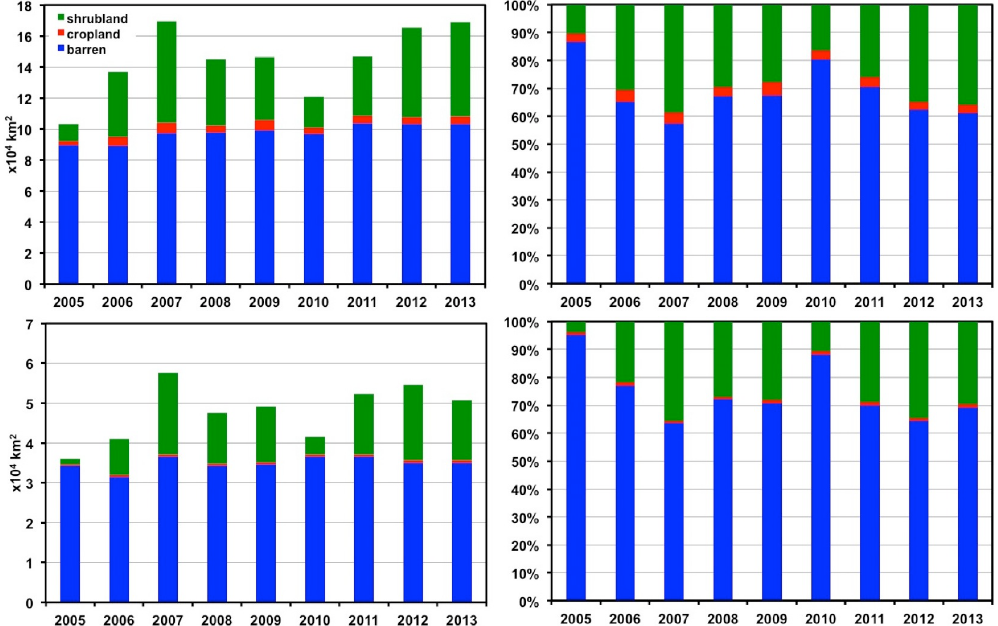
Figure 3. MODIS-derived dust sources over the western US (from the MODIS tile grid horizontal 8/vertical 5, defined in Fig. S1) and in the southwestern US (lower, defined as the region within the box in Fig. 1a), during the dust seasons in 2005–2013. The absolute source areas for three types of land cover are shown in the left column, and the contributions (%) from individual land cover types to the total source areas are shown in the right column.